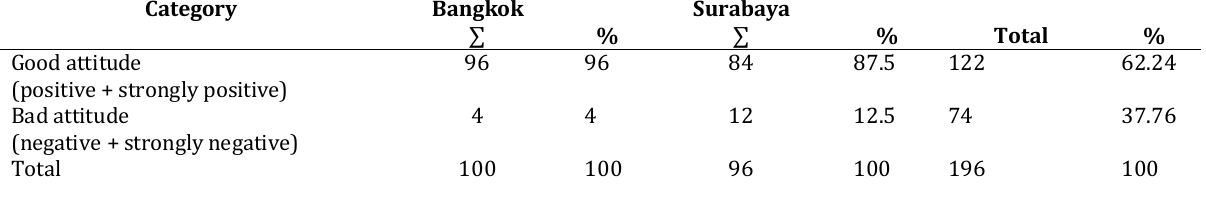
Table 5. Category of the elderly attitude towards MHE based on the level of attitude Category